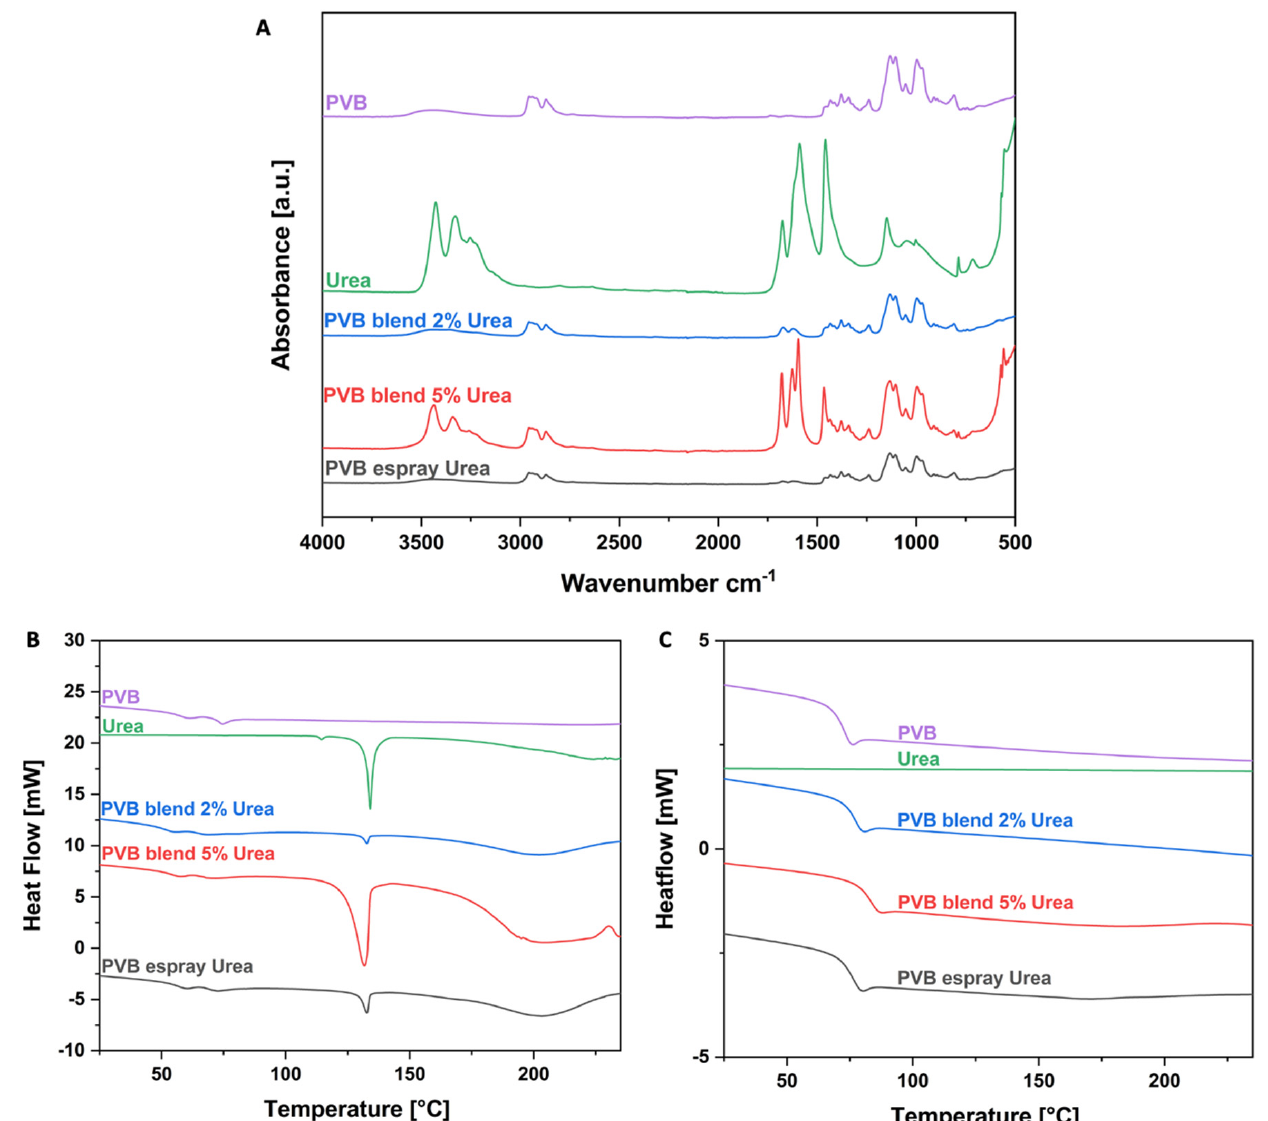
Figure 2. ( A ) The ATR-FTIR spectra of: urea powder, pristine PVB fibers, PVB blend with 2% and 5% of urea and PVB fibers electrosprayed with urea solution. DSC thermograms, ( B ) the first and ( C ) the second heating scan of PVB and urea powder, pristine PVB fibers, PVB blend with 2% and 5% of urea and PVB fibers electrosprayed with urea solution.